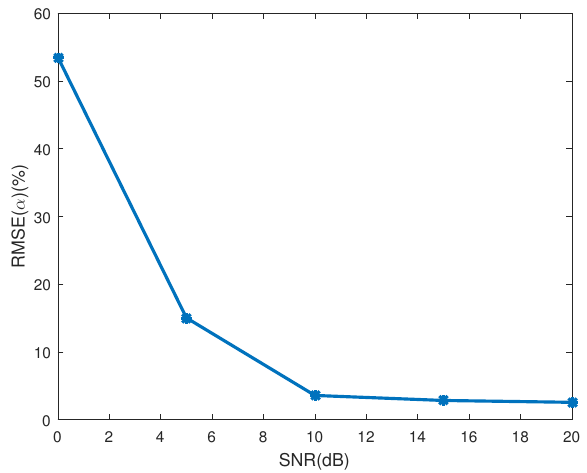
Figure 8. The estimating error of coning